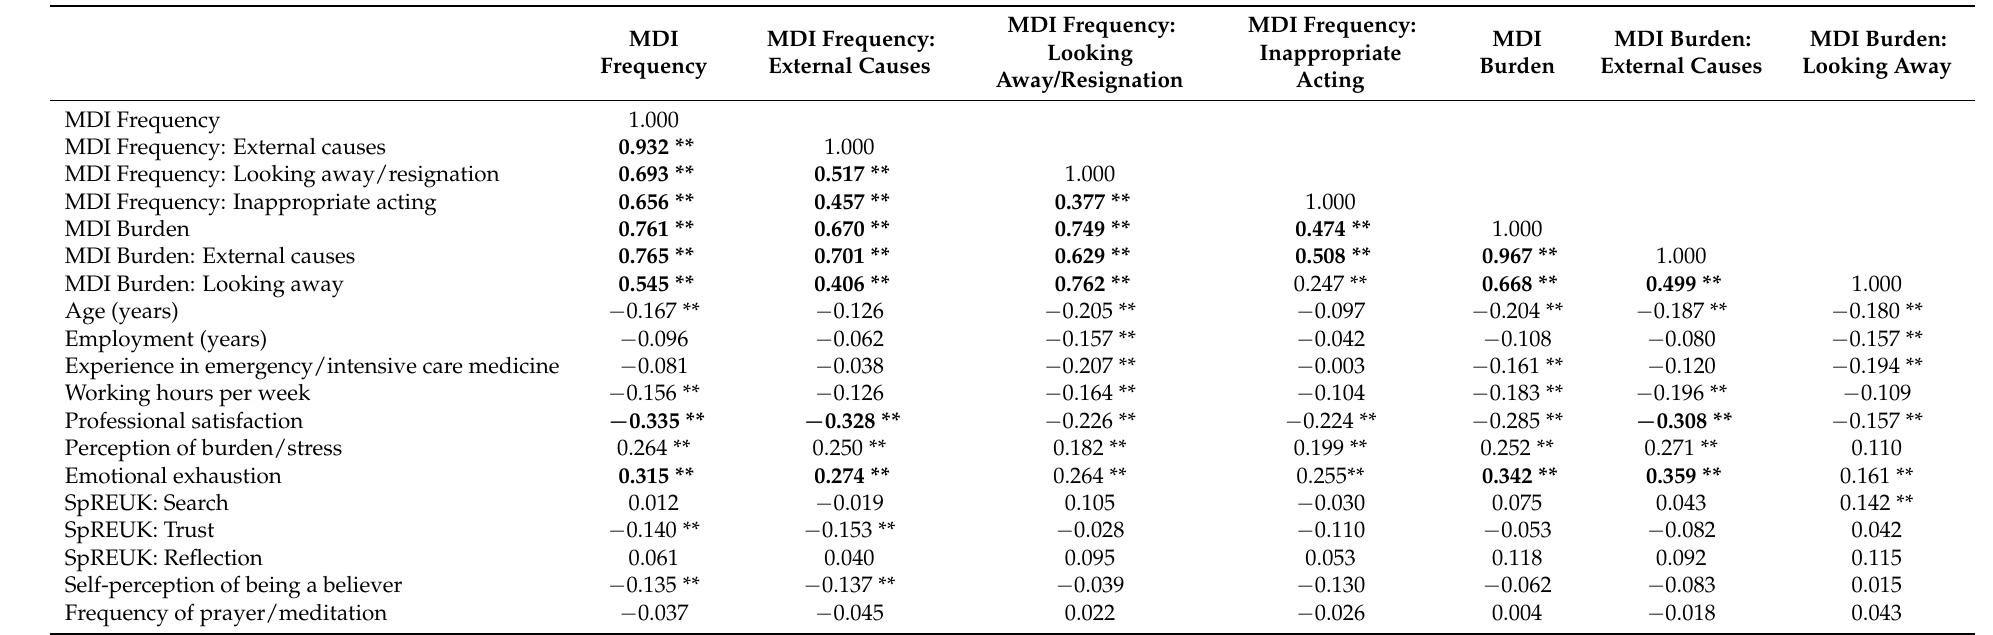
Table 3. Correlations between moral distress, stress and work-associated